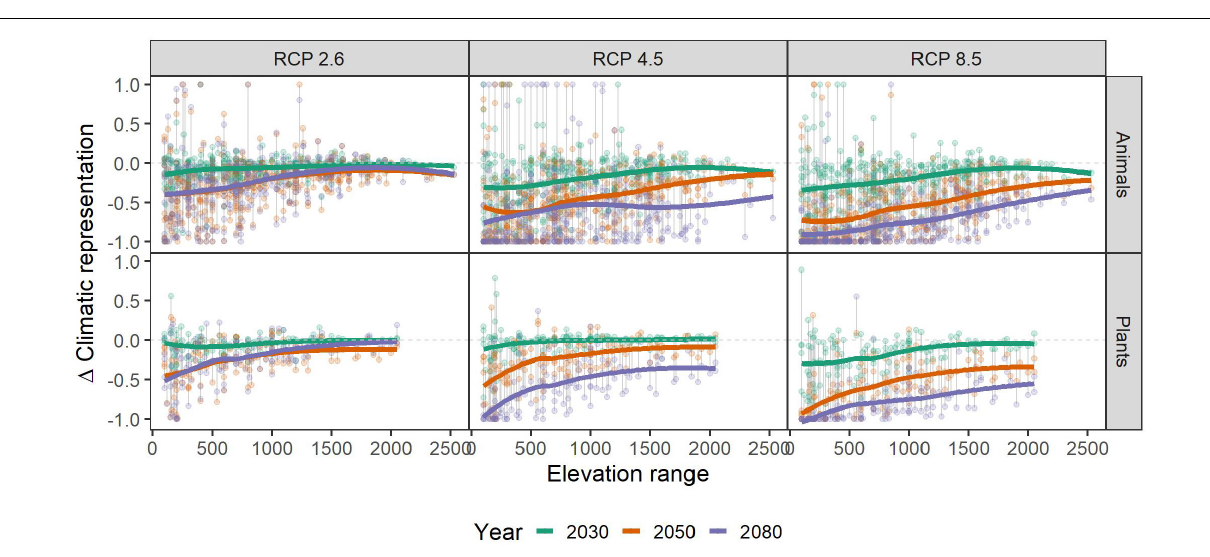
FIGURE 5 | Relationship of the species’ elevational range (in meters) and their respective gains and losses of representation in the future under climate change scenarios RCP 2.6, RCP 4.5, and RCP 8.5. Colored, bold lines represent splines within each time-step (colors) and scenario (panels) for overview. Gray vertical lines connect data points belonging to one species. A value of -1 means complete loss of representation, and a value of 1 means a doubling of representation. Please note that some species had a relative change > 1, and that for overview, we set those to 1. See Supplementary Table 1 for